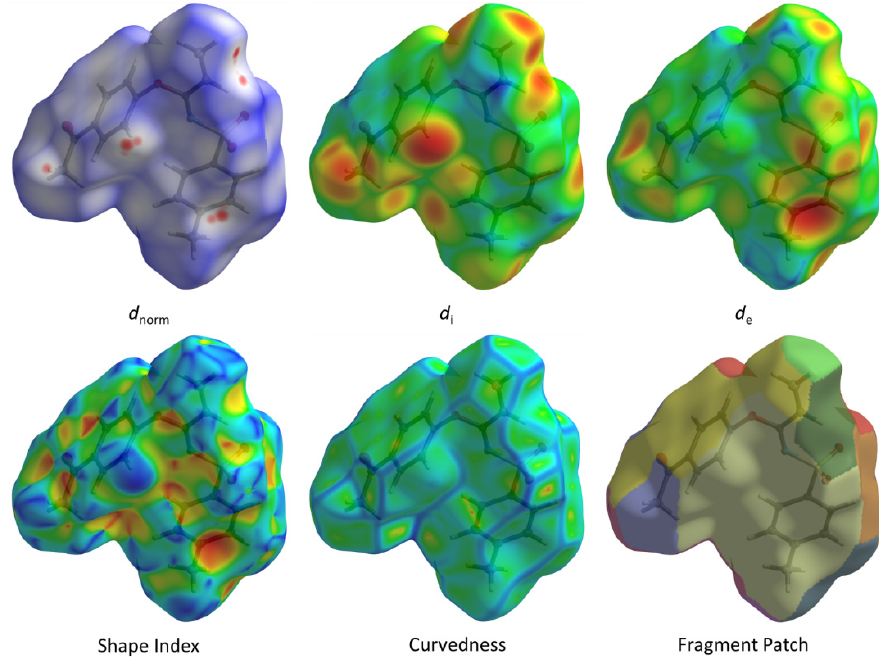
Figure 6. Hirshfeld surface for 3 with d norm , d i , d e , shape index, curvedness and fragment patch.